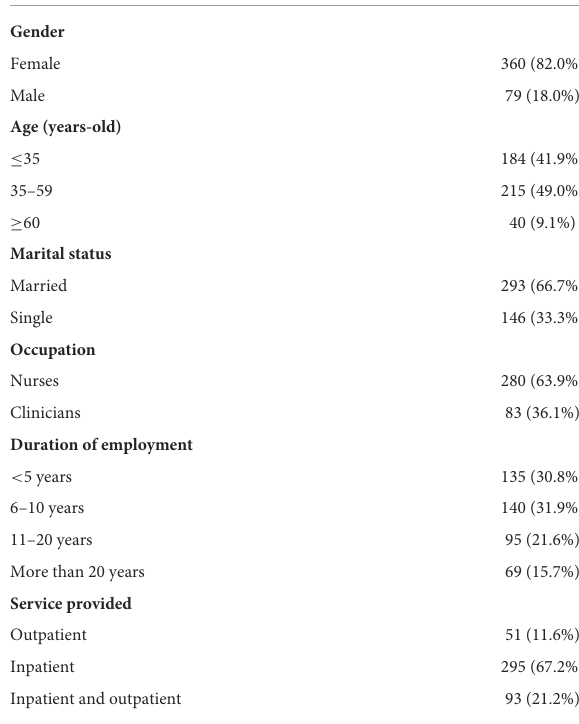
TABLE 1 Demographic characteristics of